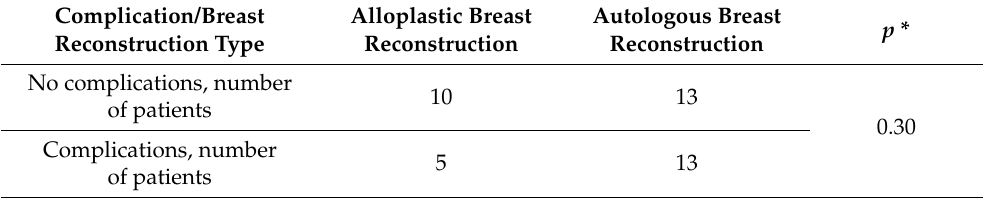
Table 3. Correlation between breast reconstruction type and complications in the RT